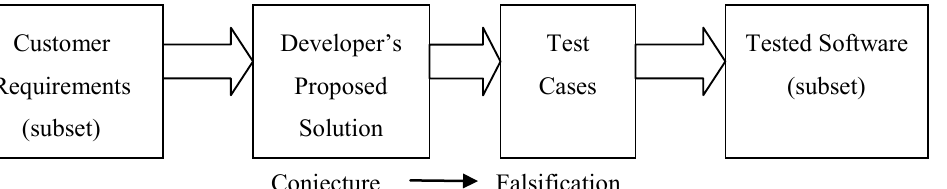
Figure 1. Northover et al. ’s 4 stage model of agile